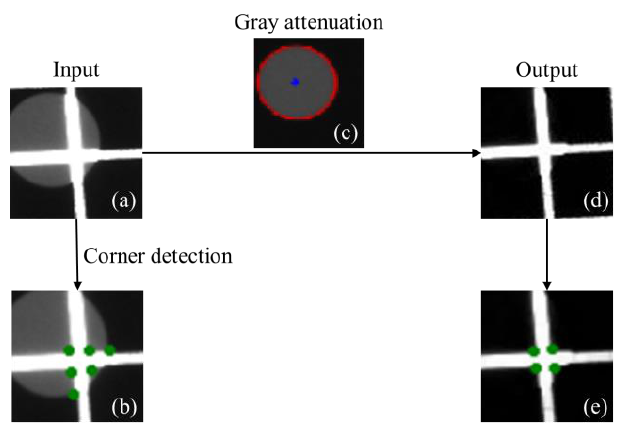
Figure 5. Image gray attenuation for the grid pattern on white circles. ( a ) Input image; ( b ) The error occurred of corner detection on the input image; ( c ) Gray attenuation process; ( d ) The output image after the attenuation; ( e ) The correct corner detection result.